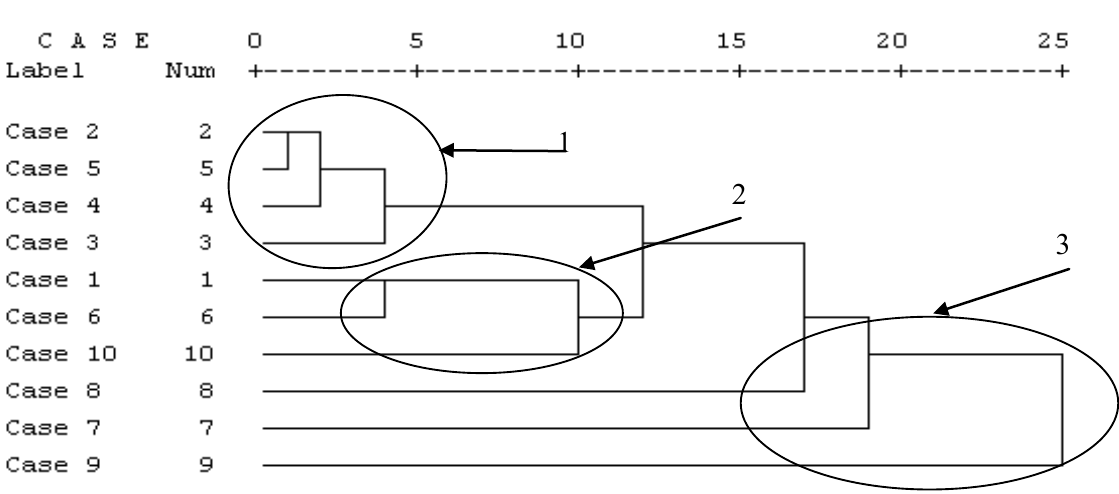
Fig.2 Dendogram of cluster analysis of distribution in groups of Ukrainian combined team players with hearing problems, in compliance with indicators of complex testing: 1 – first cluster, forwards; 2 – second cluster, backs; 3 – third cluster, central players; Rescaled Distance Cluster Combine – Conventional scale of differences between players with their combining in clusters by indicators of complex testing; Case – the tested, conventional number; Num – number; Labe –